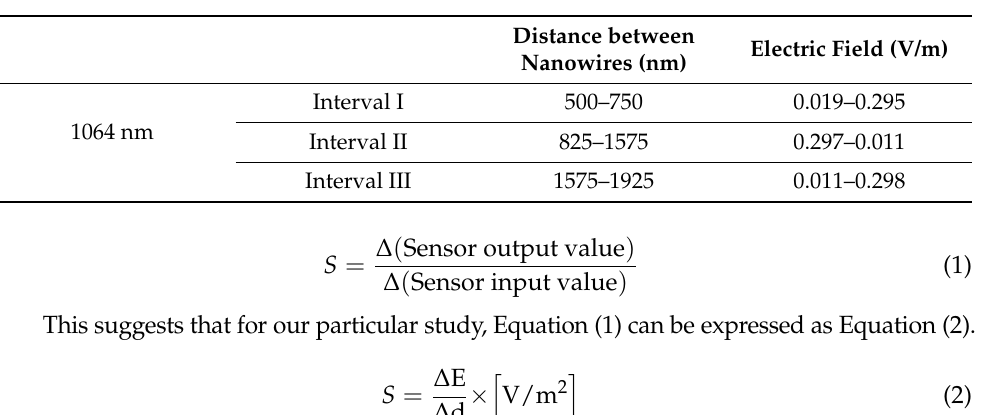
Table 1. Most significant intervals of the scattered field for λ = 1064 nm.